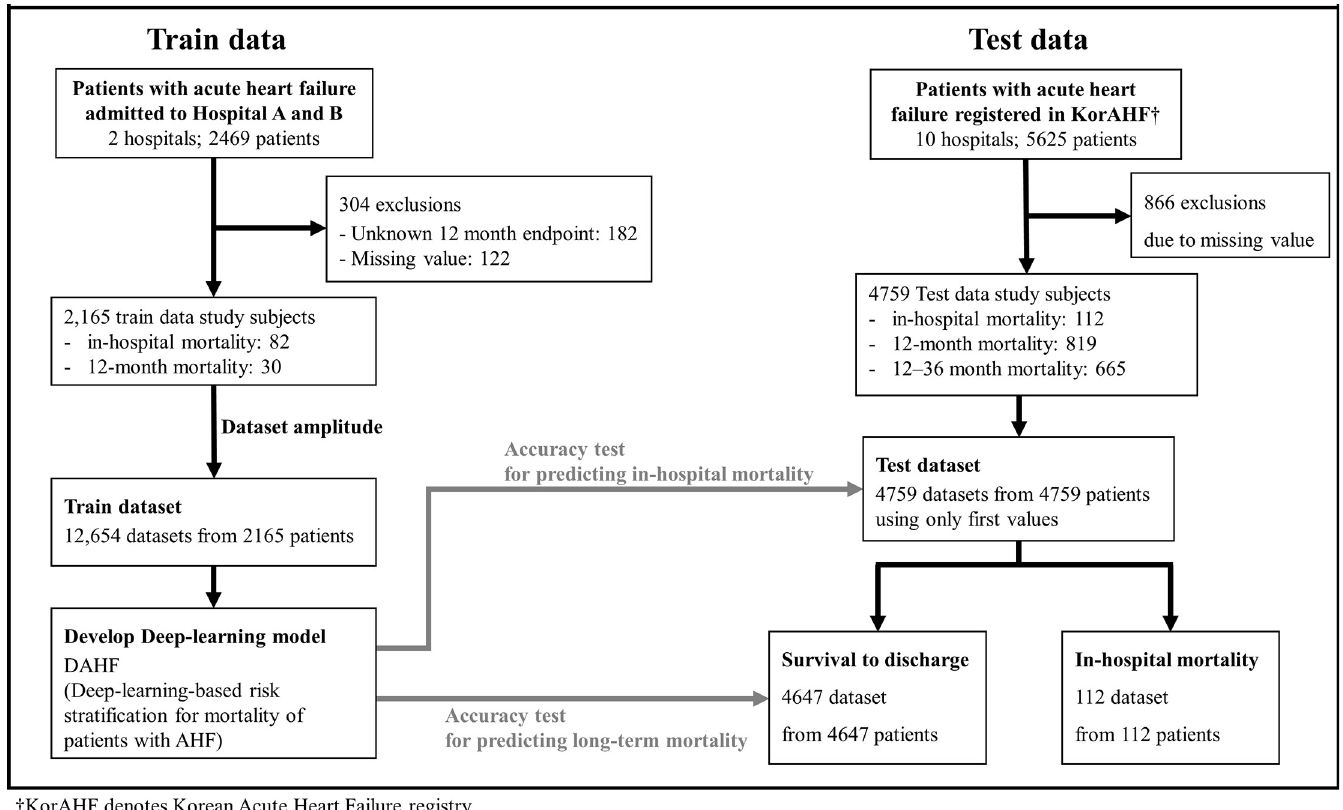
Fig 1. Study flowchart. KorAHF denotes Korean Acute Heart Failure